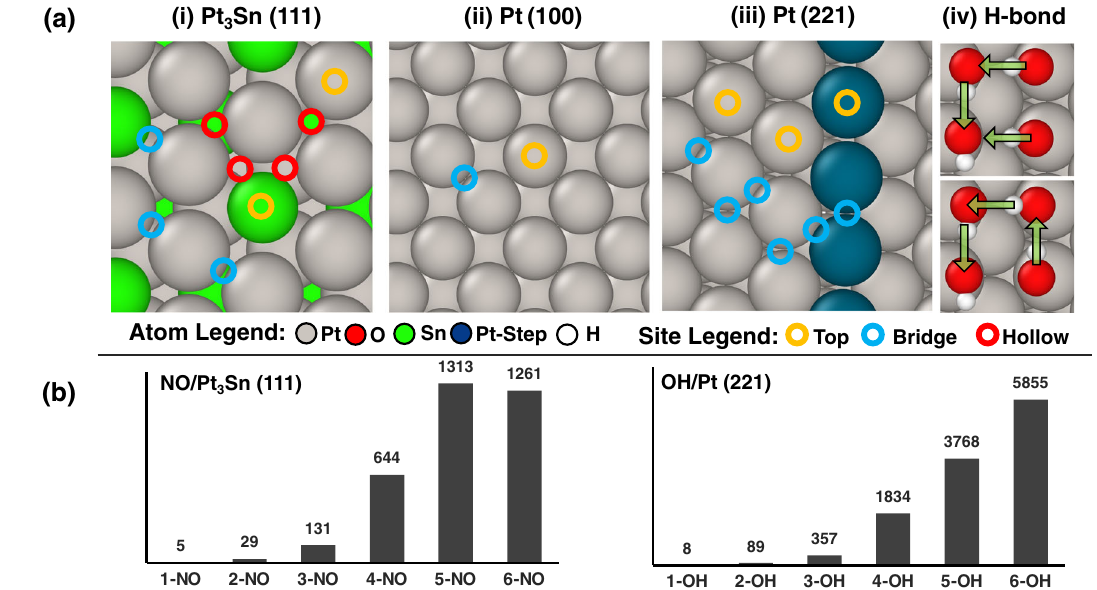
Fig. 2 | Catalyst con fi gurations analyzed with ACE-CGN. a Structural motifs considered in the catalyst models: (i) alloying (Pt 3 Sn(111)), (ii) diversity of binding sites on Pt(100) and (iii) Pt(221) (terrace in gray, step in blue) surfaces, and (iv) directionally dependent intermolecular interactions between adsorbates, such as